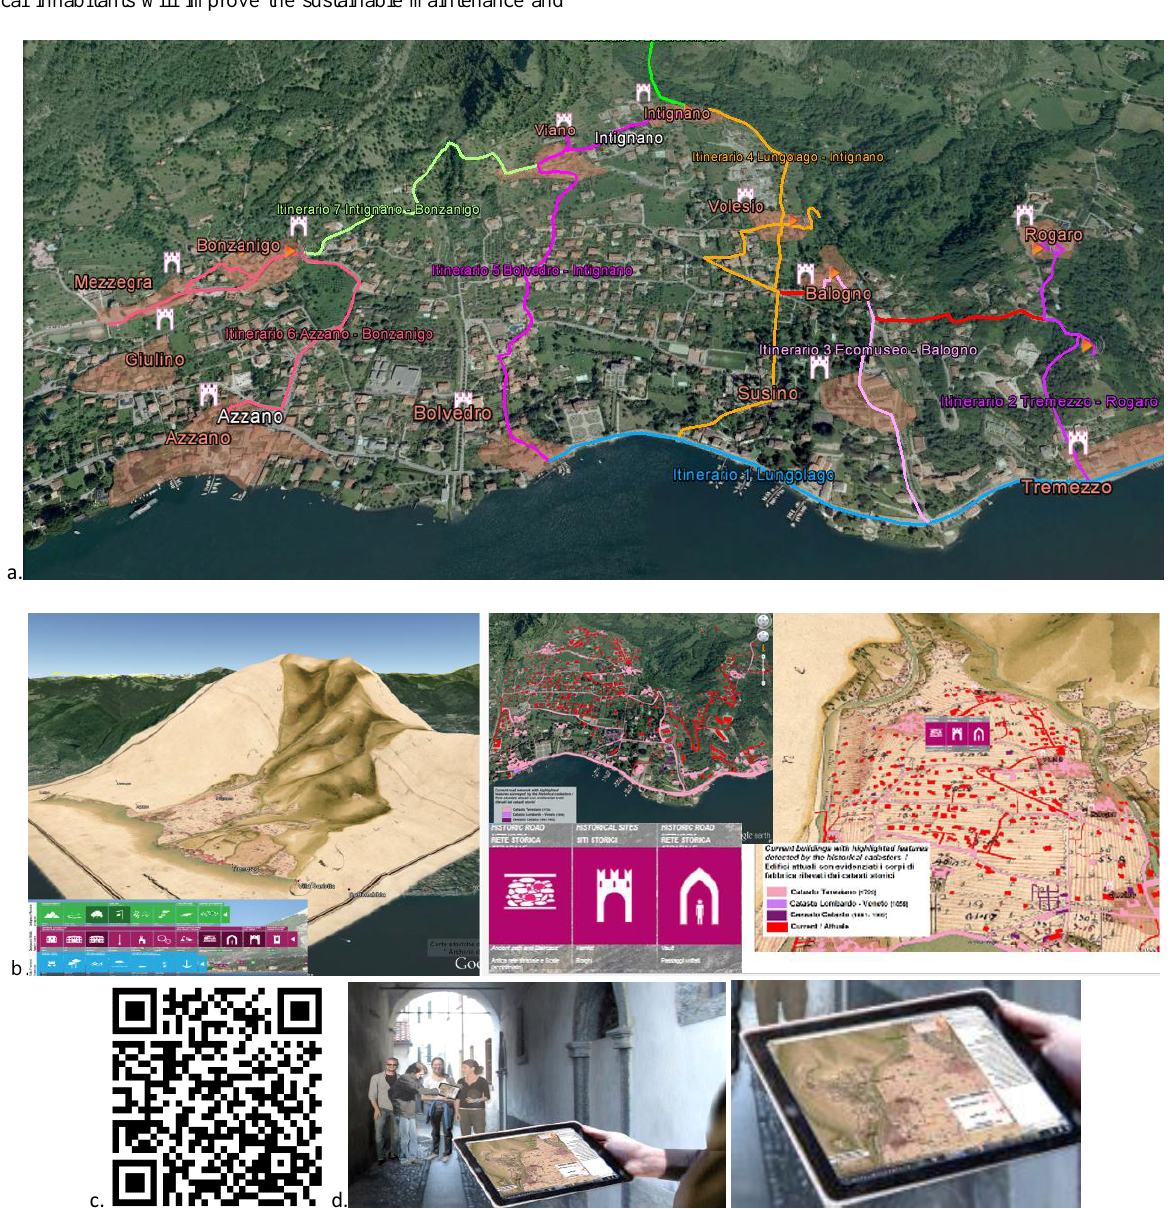
Figure 7. Tremezzo itineraries accessible online (a) along with some other thematic layers (b). The QR code to access application contents (c) and iPad visualization